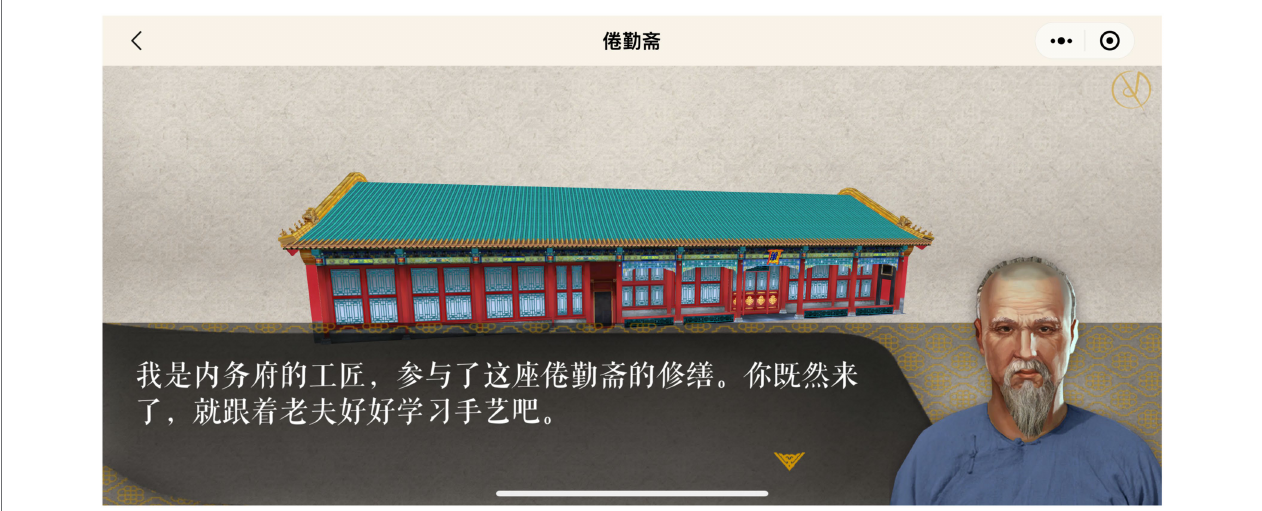
FIGURE 2 | DPM: guided VR experience (the texts on the top of the figure show the name of the building “Qinjuanzhai”; the role in the figure says: I am a craftsman of the Imperial Household Department and participated in the repair of the House of Qinjuanzhai. Since you are here, you can learn the craft well with me).